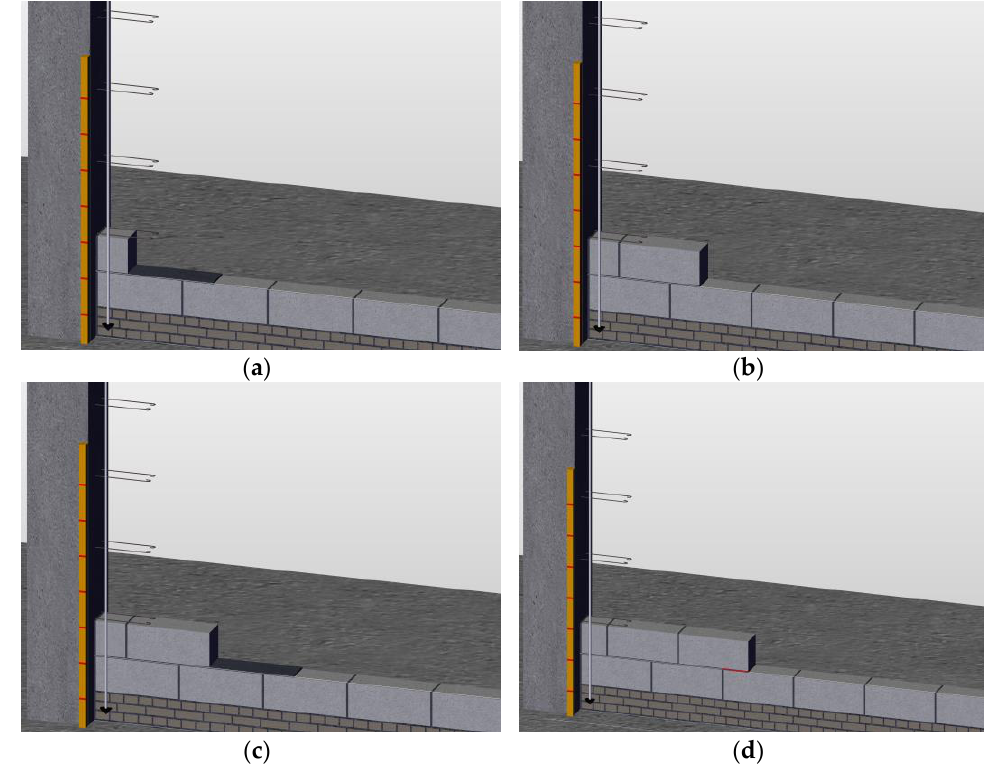
Figure 9. Three-one masonry key views: ( a ) the first step of masonry; ( b ) the second step of masonry; ( c ) the third step of masonry; ( d ) the fourth step of masonry.